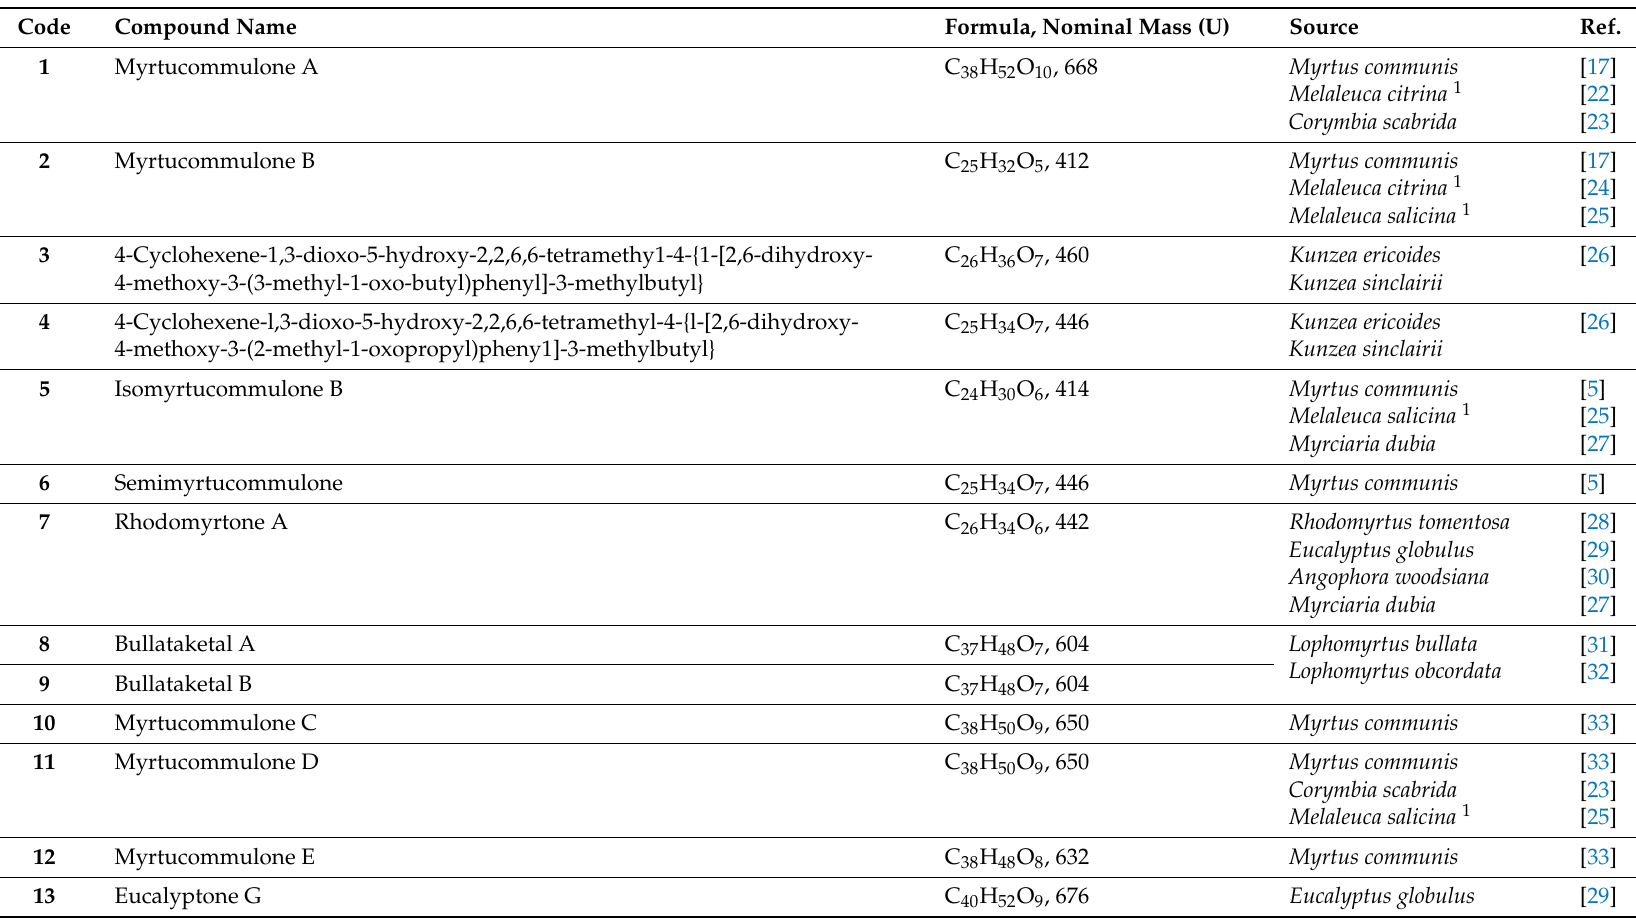
Table 1. Myrtucommulones and related compounds reported from plant species belonging to the Myrtaceae. Compounds are listed according to the chronological order of